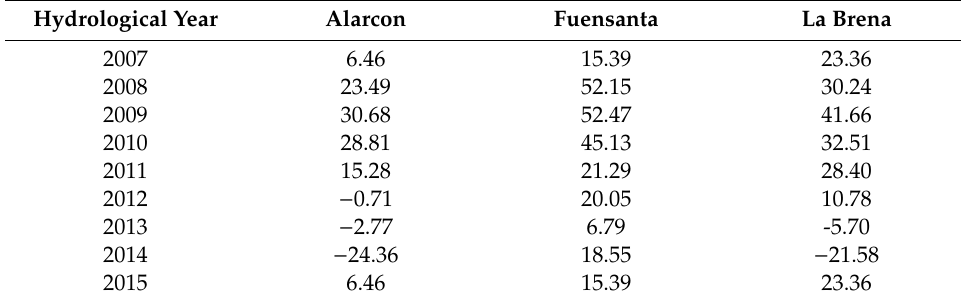
Table 4. Model performance (PBIAS (%)) of simulated versus observed storage for period 2007–2015 for three